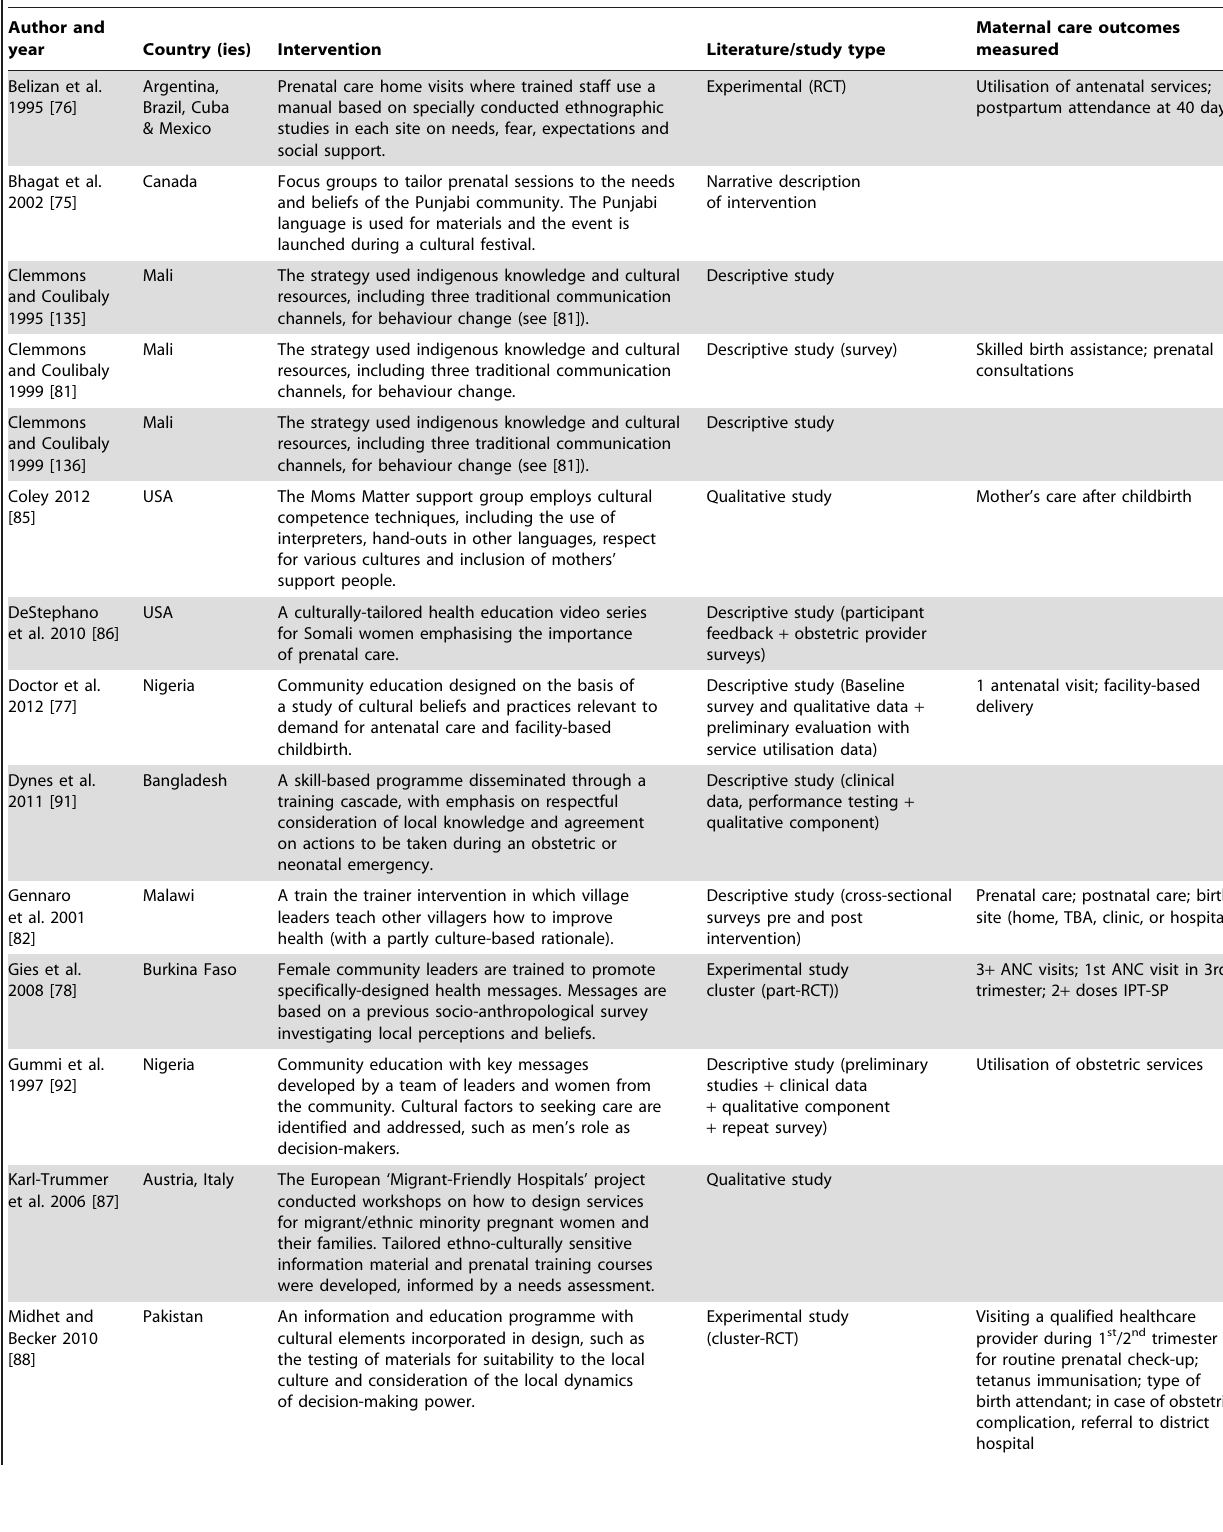
Table 5. Included items: Health education